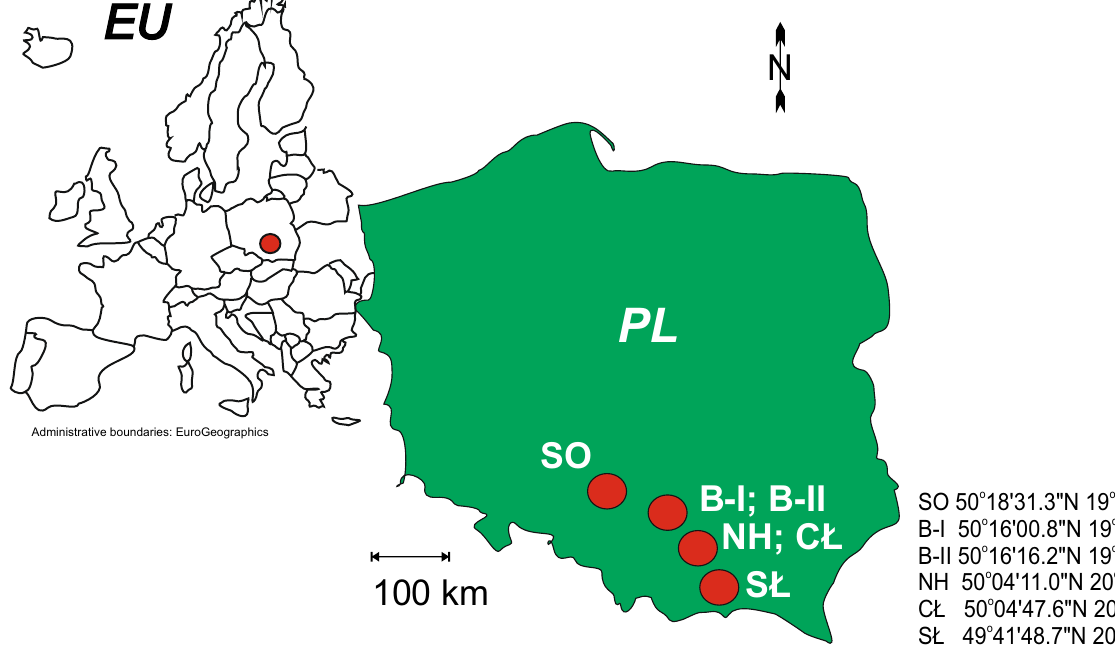
Figure 1. Sampling sites. The map was created by the authors using CorelDRAW2020 software, ver. 22.1.1.523; based on: https ://ec.europ a.eu/euros tat/docum ents/ © EuroGeographics for the administrative